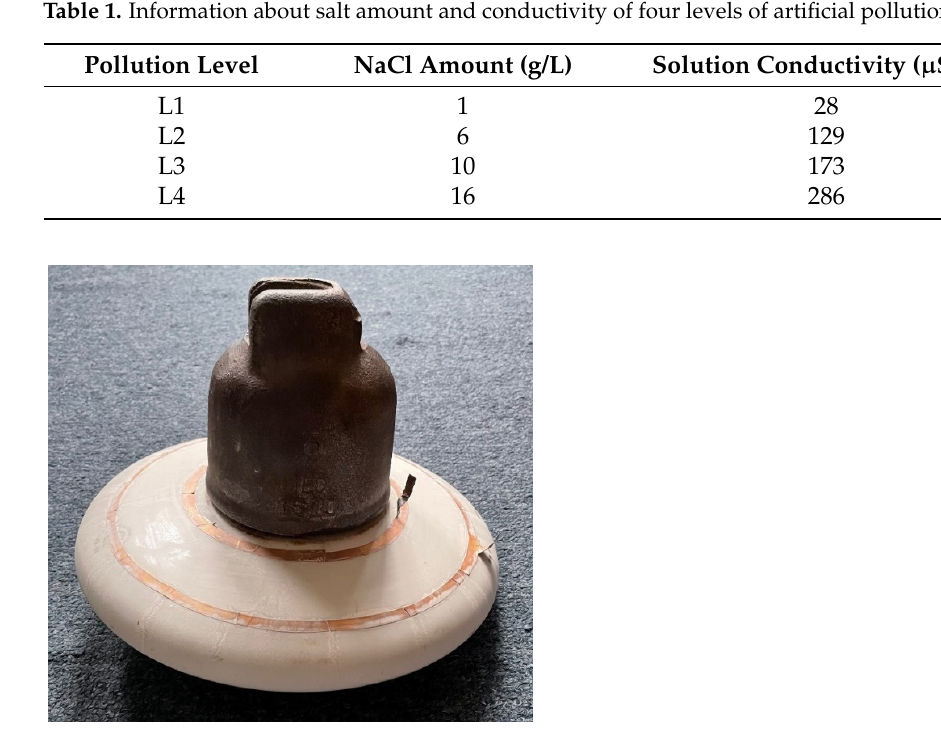
Figure 3. Porcelain insulator contaminated by second pollution level